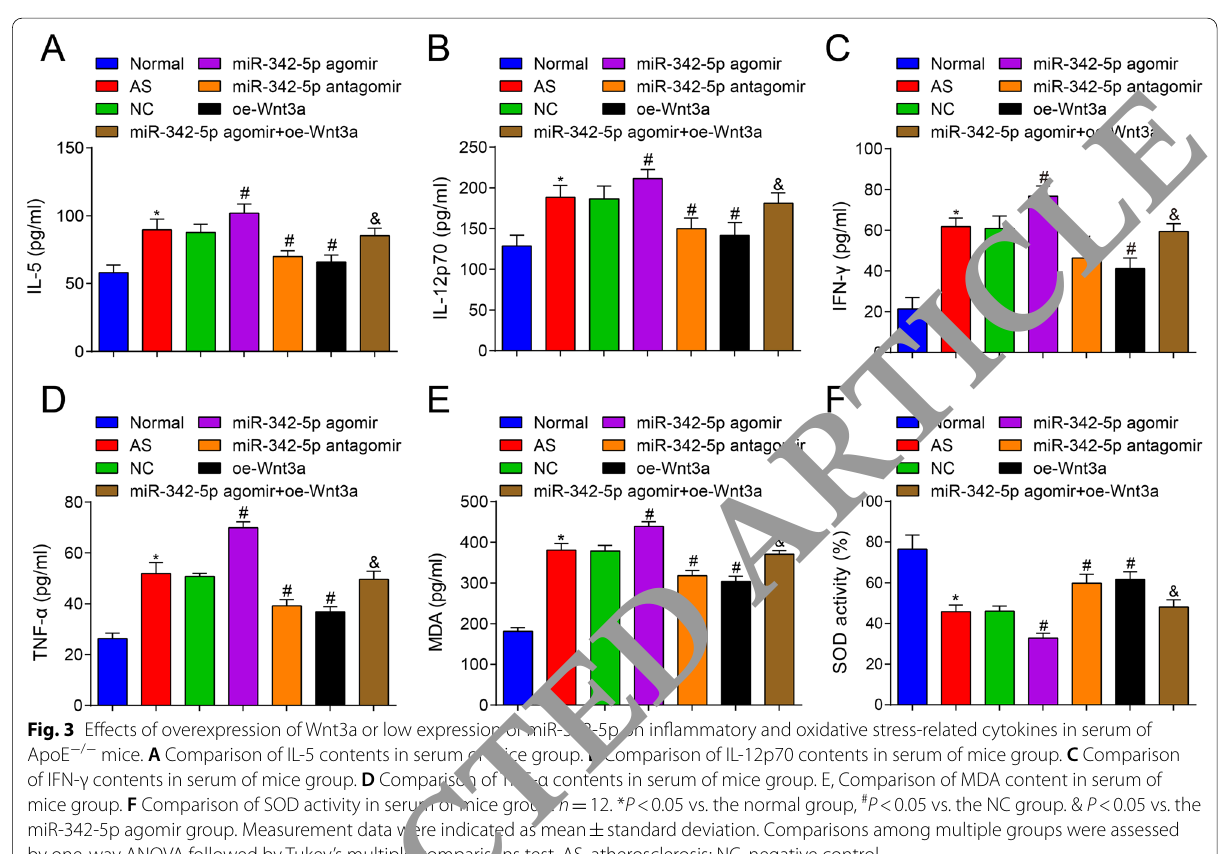
Fig. 3 Effects of overexpression of Wnt3a or low expression of miR-342-5p on inflammatory and oxidative stress-related cytokines in serum of ApoE − / − mice. A Comparison of IL-5 contents in serum of mice group. B Comparison of IL-12p70 contents in serum of mice group. C Comparison of IFN-γ contents in serum of mice group. D Comparison of TNF-α contents in serum of mice group. E, Comparison of MDA content in serum of mice group. F Comparison of SOD activity in serum of mice group. n 12. * P < 0.05 vs. the normal group, # P < 0.05 vs. the NC group. & P < 0.05 vs. the = miR-342-5p agomir group. Measurement data were indicated as mean standard deviation. Comparisons among multiple groups were assessed ± by one-way ANOVA followed by Tukey’s multiple comparisons test. AS, atherosclerosis; NC, negative